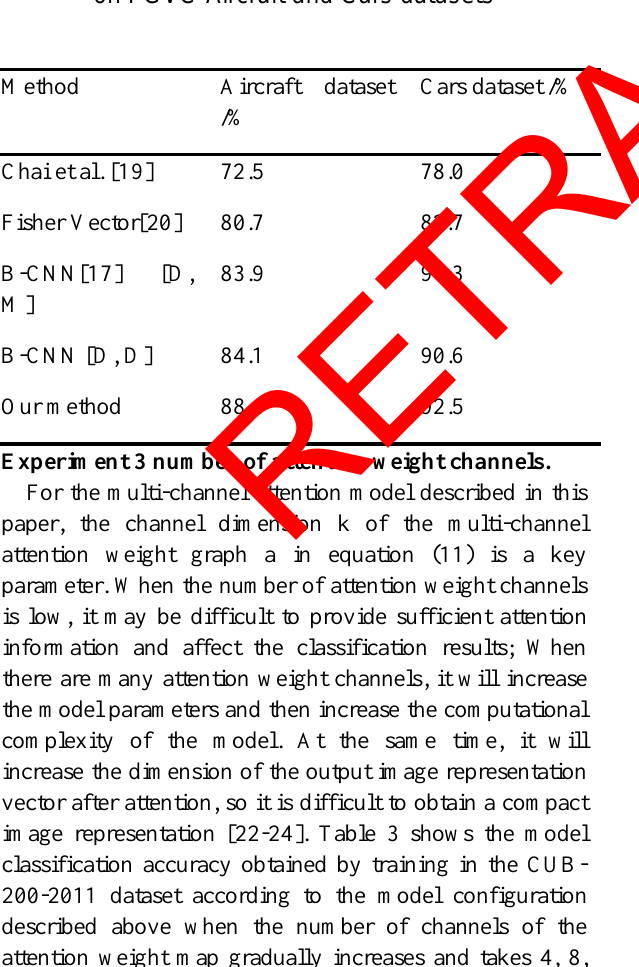
Table 2. Classification accuracy of different methods on FGVC-Aircraft and Cars datasets